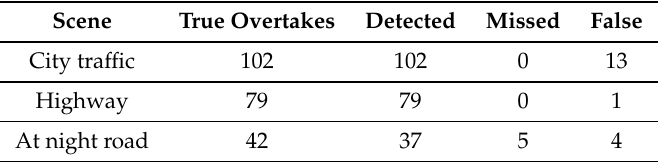
Table 4. The experimental results and performance